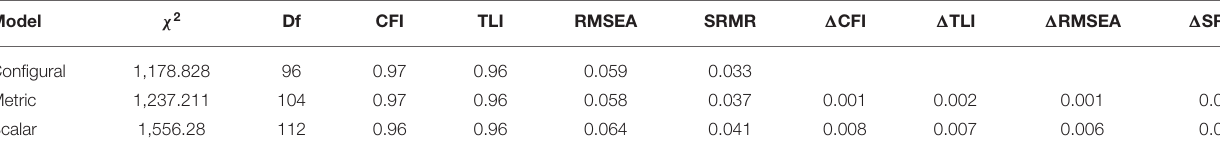
TABLE 5 | Fit indicators to assess the invariance of the EduFlow-2 scale measure for the sample.